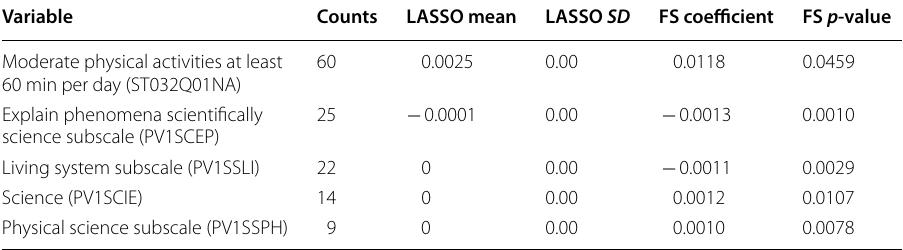
Table 7 Statistically significant variables with FS and selected < 75 with